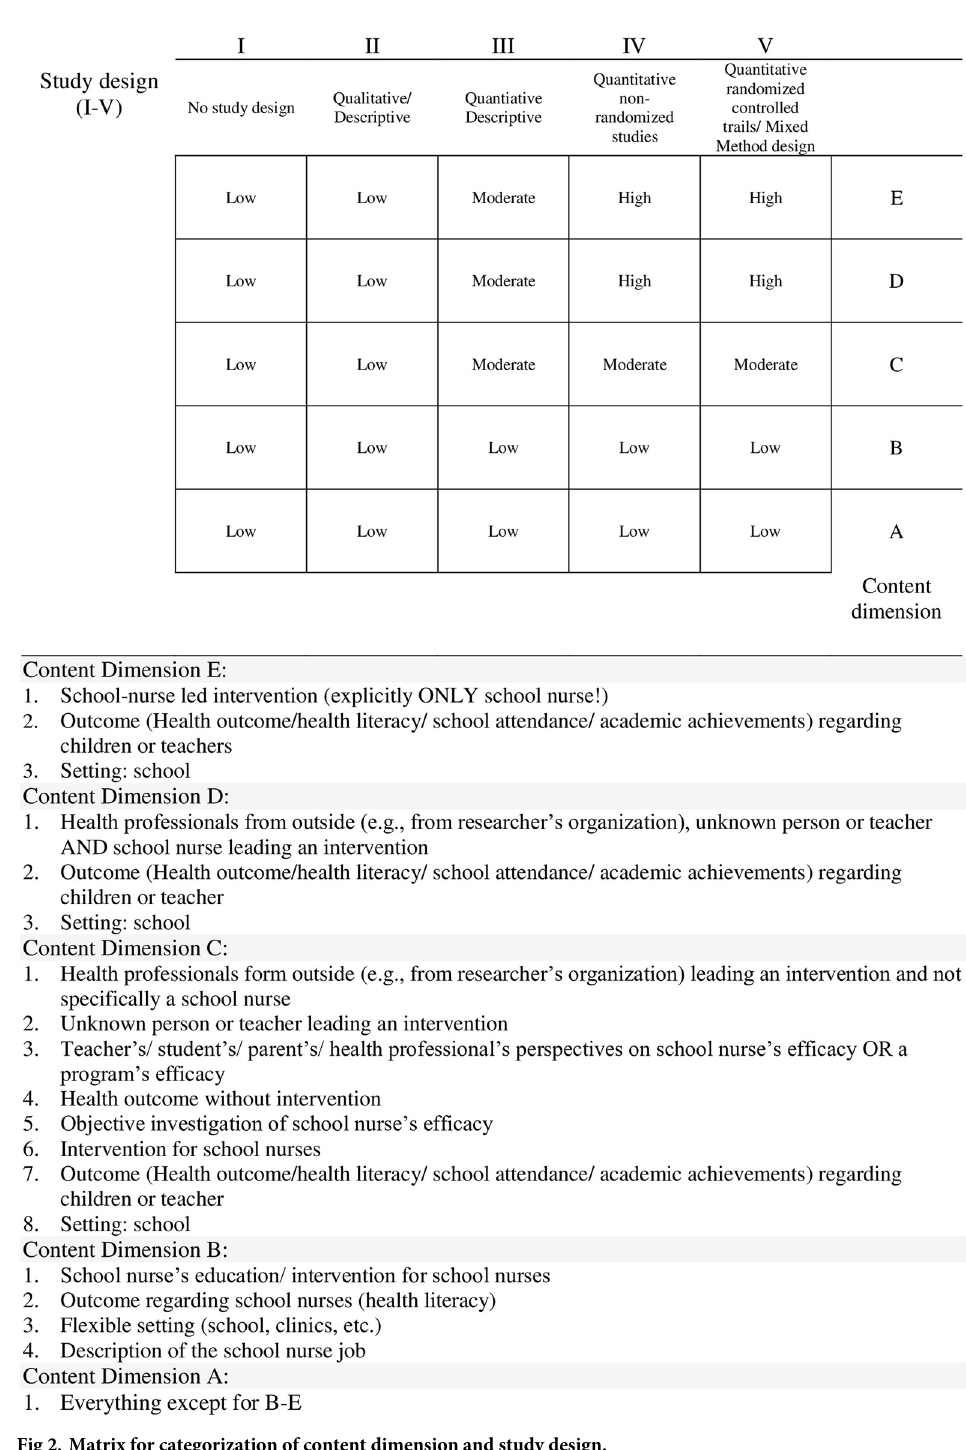
Fig 2. Matrix for categorization of content dimension and study